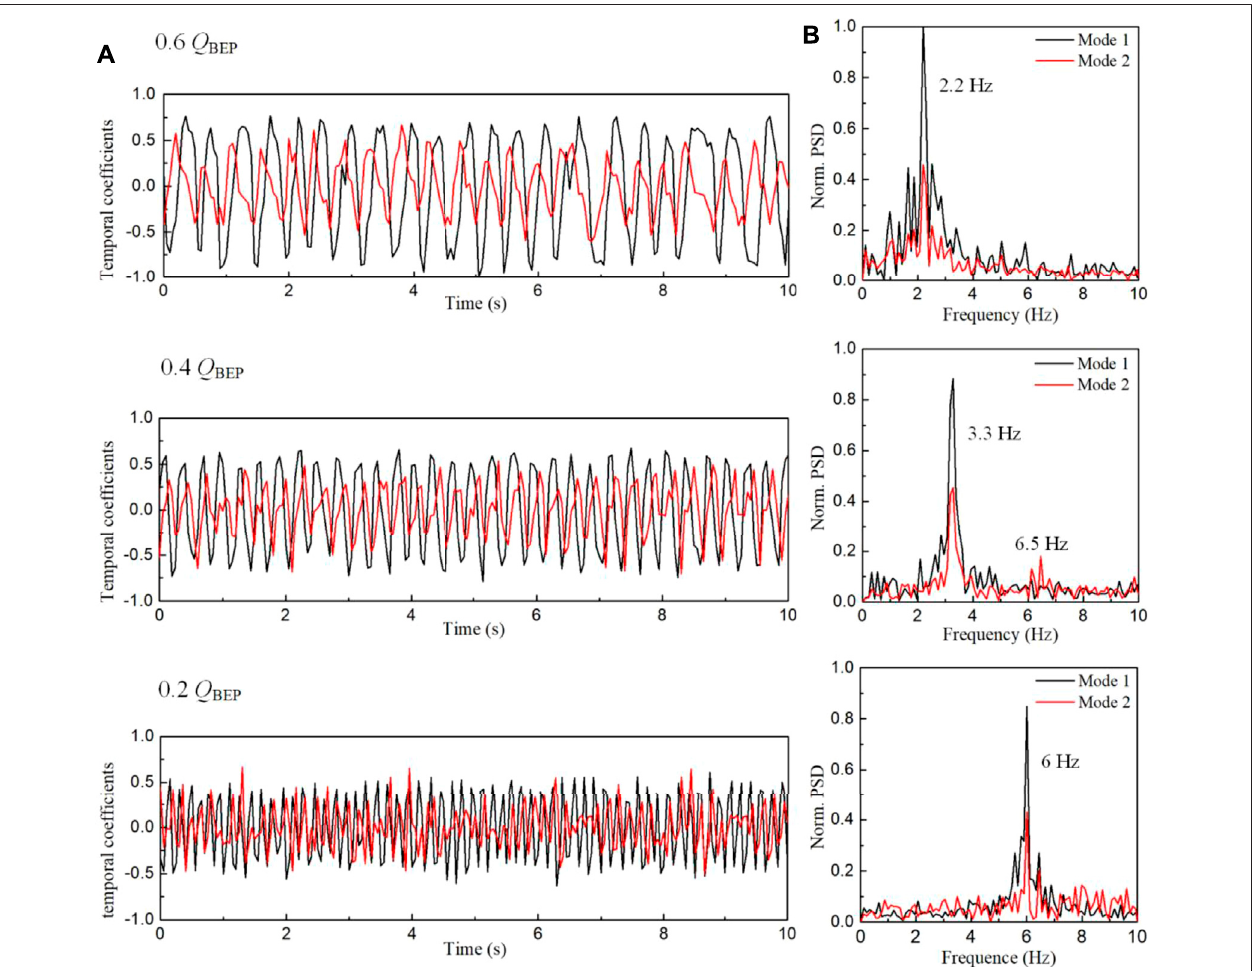
FIGURE 8 | Temporal characteristics of mode 1 and mode 2. (A) Temporal coef fi cients of the fi rst two modes; (B) FFT distribution of the fi rst two modes.